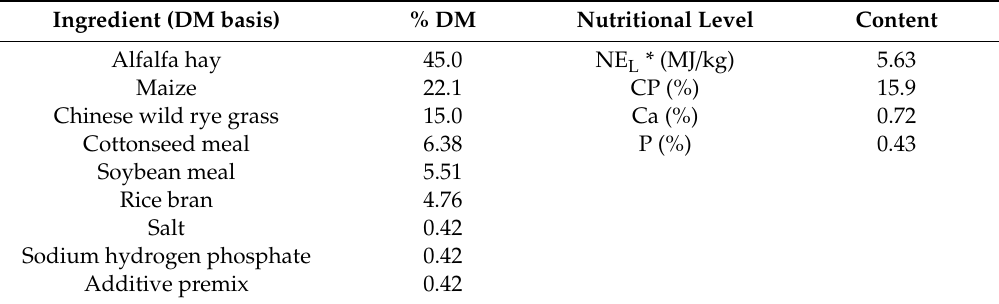
Table 1. Ingredients and nutritional level of